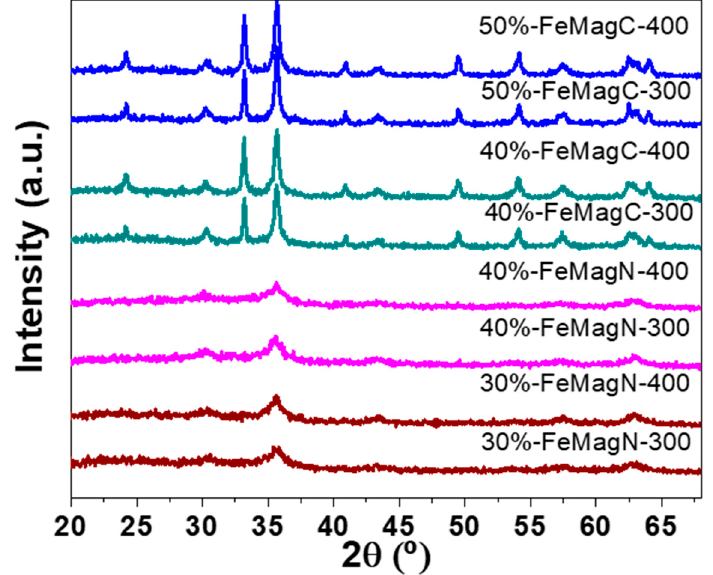
Figure 1. X-ray diffraction (XRD) patterns of selected samples.